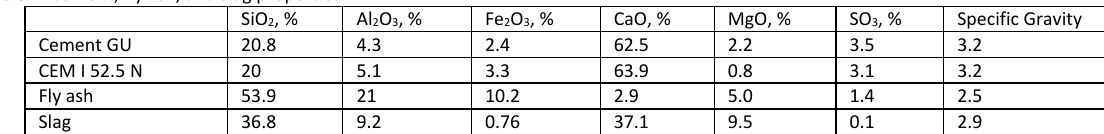
Table 1. Cement, fly ash, and slag properties. SiO 2 , % Al 2 O 3 , % Fe 2 O 3 , % CaO, % MgO, % SO 3 , % Specific Gravity Cement GU